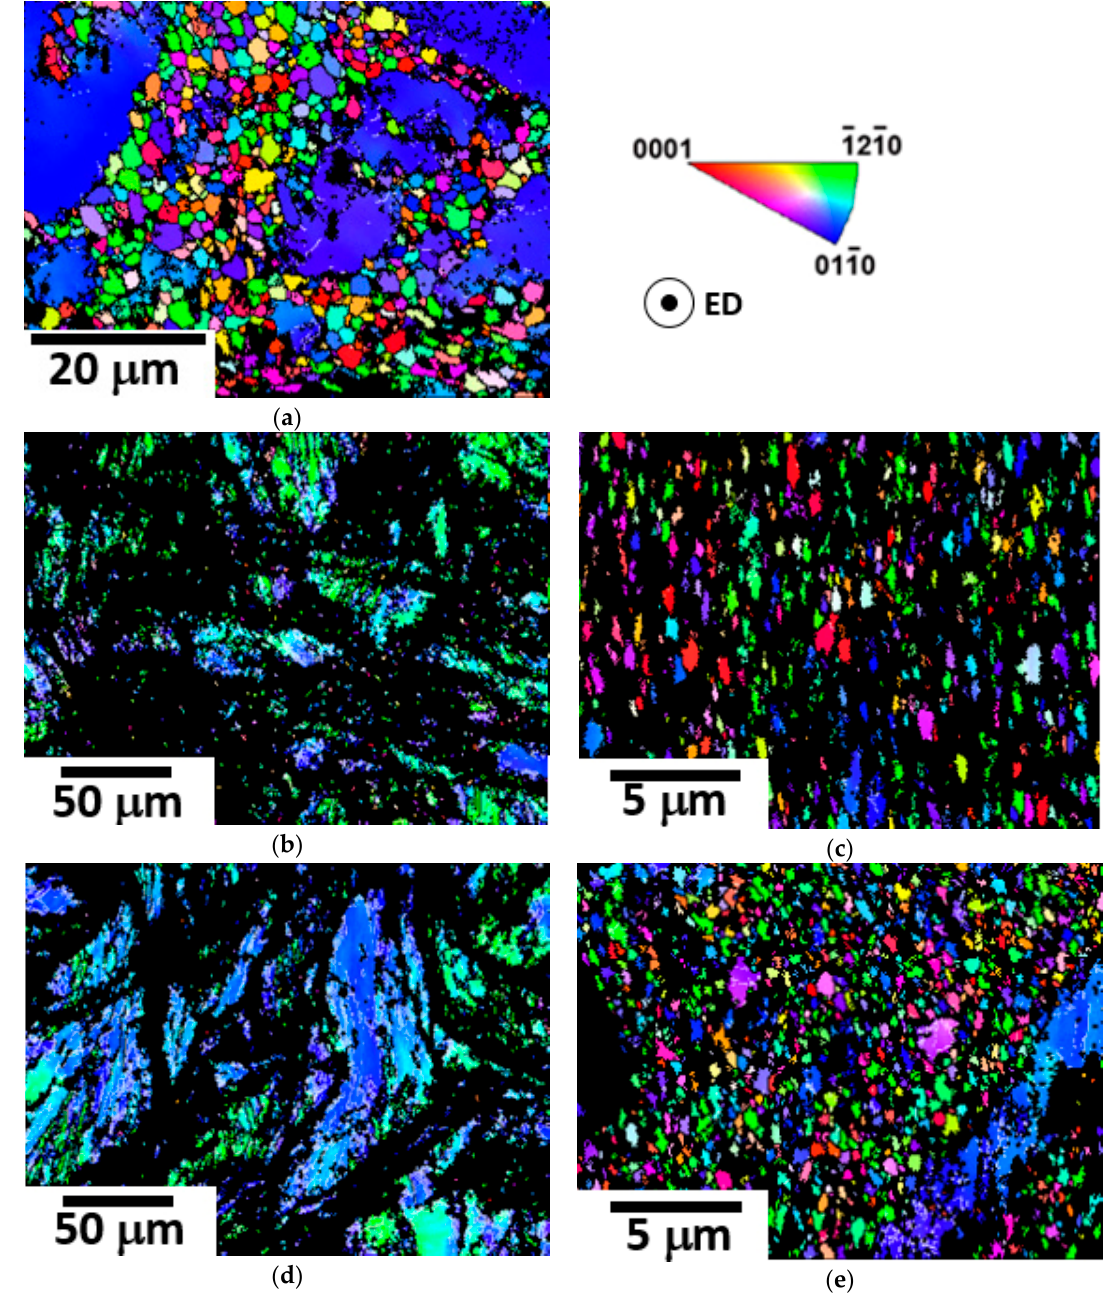
Figure 5. Orientation Image Mapping of the extruded GWZ831 alloy after ( a ) 0, ( b , c ) 4, and ( d , e ) 6 ECAP passes. Extrusion or ECAP direction is perpendicular to the image.